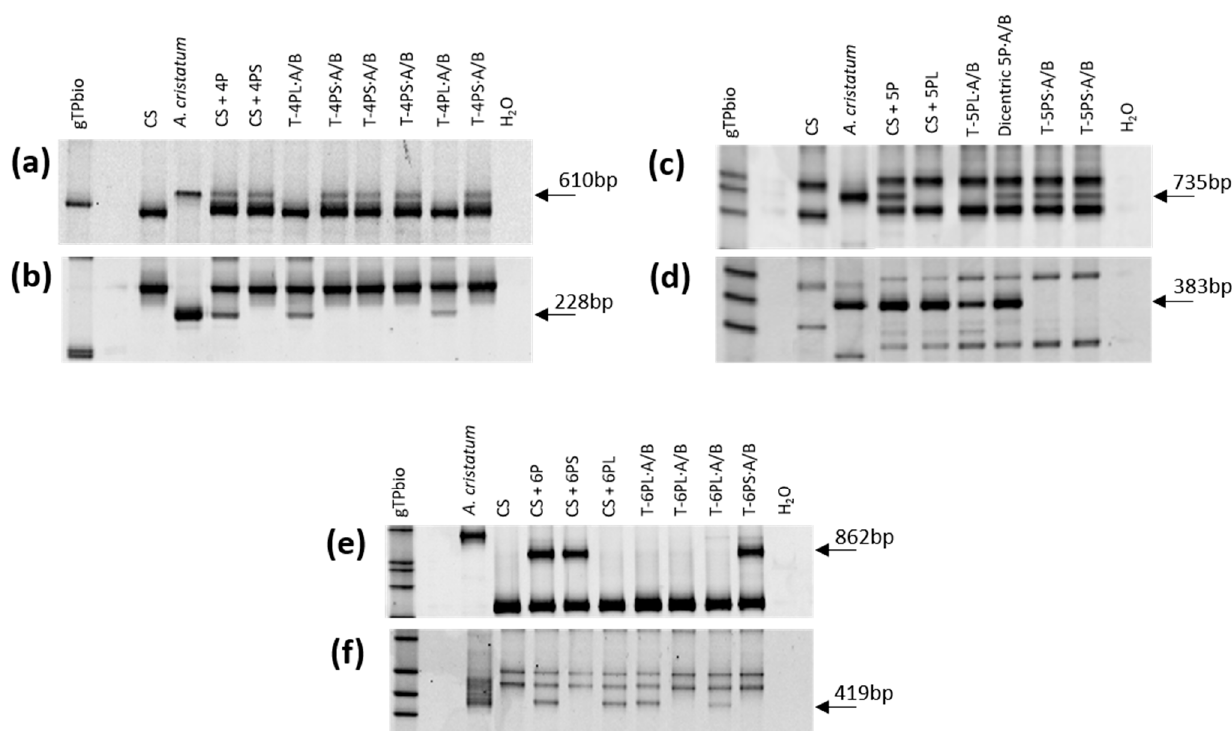
Figure 4. Molecular characterization of wheat- A.cristatum translocation lines using chromosome-specific COS markers. ( a ) C:757404-4PS; ( b ) C:739175-4PL; ( c ) C:728036-5PS; ( d ) C:762245-5PL; ( e ) C:741456-6PS; ( f ) C:755292-6PL. The differences in the size of the amplified COS fragment in the A. cristatum genome used as control and the A. cristatum chromosome present in the addition lines for some markers are due to genetic differences between the A. cristatum accession used in this study and the accession used to obtain the addition lines.